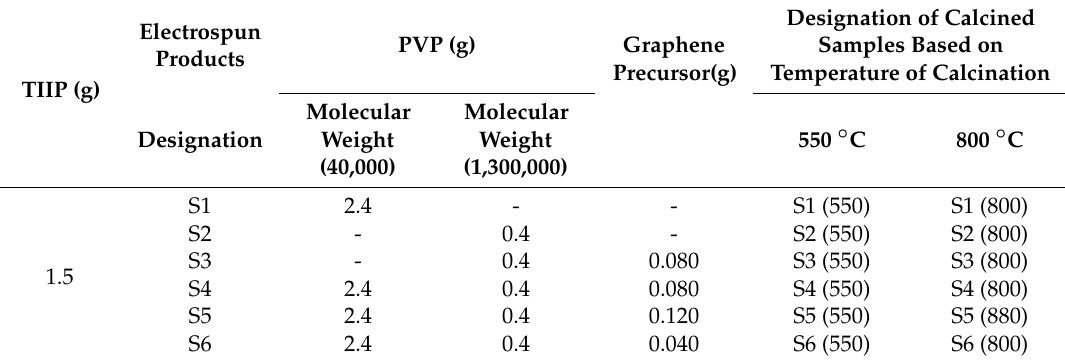
Table 1. Electrospun dope compositions and sample